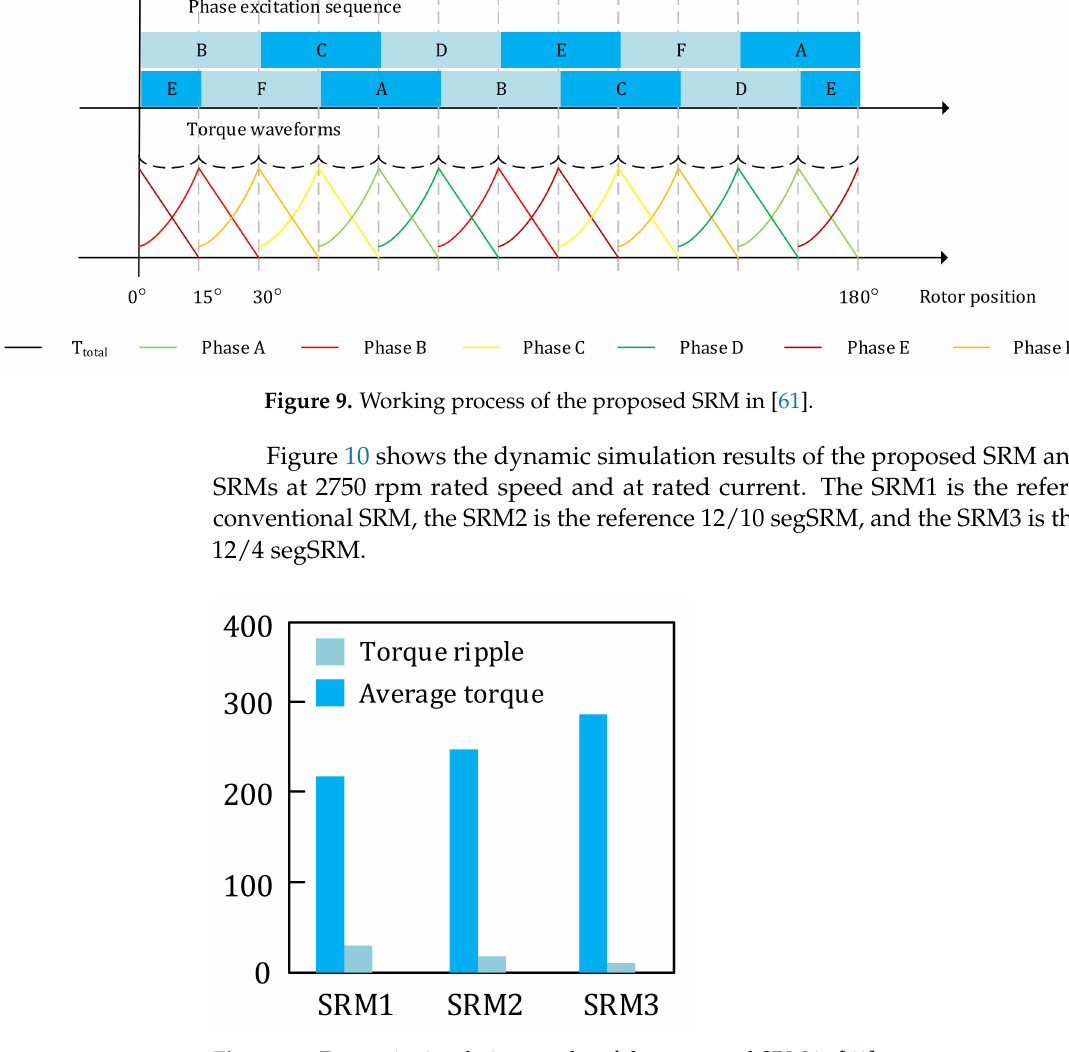
Figure 10. Dynamic simulation results of the proposed SRM in